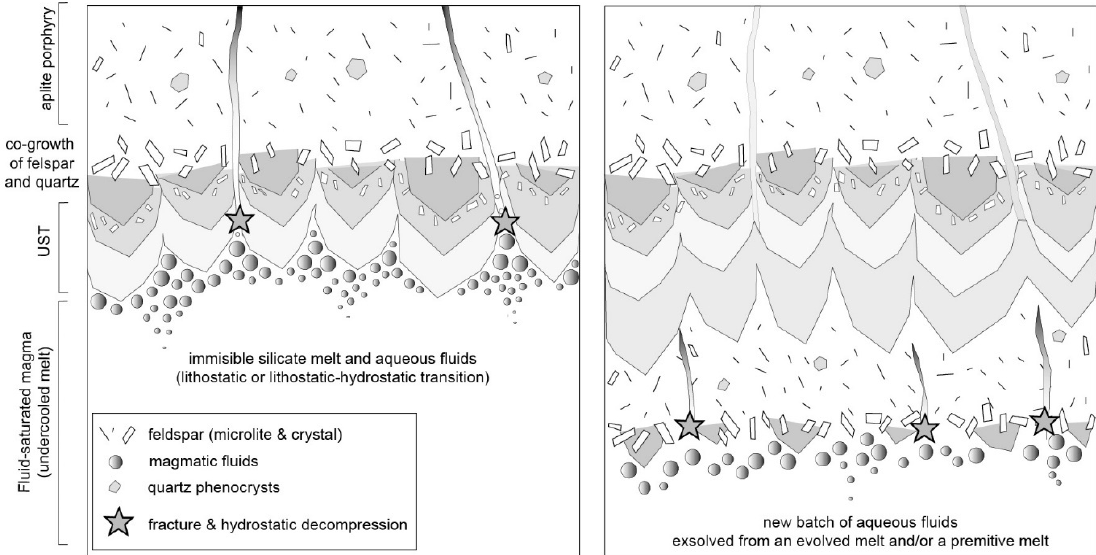
Figure 11. Schematic and interpretive drawings of generation of Eonyang UST in the Sannae-Eonyang granite. In the upper part (approximately > 8 km below paleosurface) of the crystallizing granitic magma of the Sannae-Eonyang granite, lithostatic pressure accumulated by aqueous fluid release from an undercooled silicate melt will shift the cotectic boundary from co-growth of feldspar and quartz into quartz-only phase crystallization. Hydrofracturing will cause transient hydrostatic pressures and fluid-phase separation, but the pressure will rise subsequently by the sealing of secondary quartz. Highly fluctuating pressures will continue during the formation of a sequence of UST until the cessation of a single batch of magmatic fluid releasing. After magmatic fluid release, the undercooled and residual melt will be quenched to form a fine-grain aplite porphyry. New batches of magmatic fluid are required to form a later sequence of